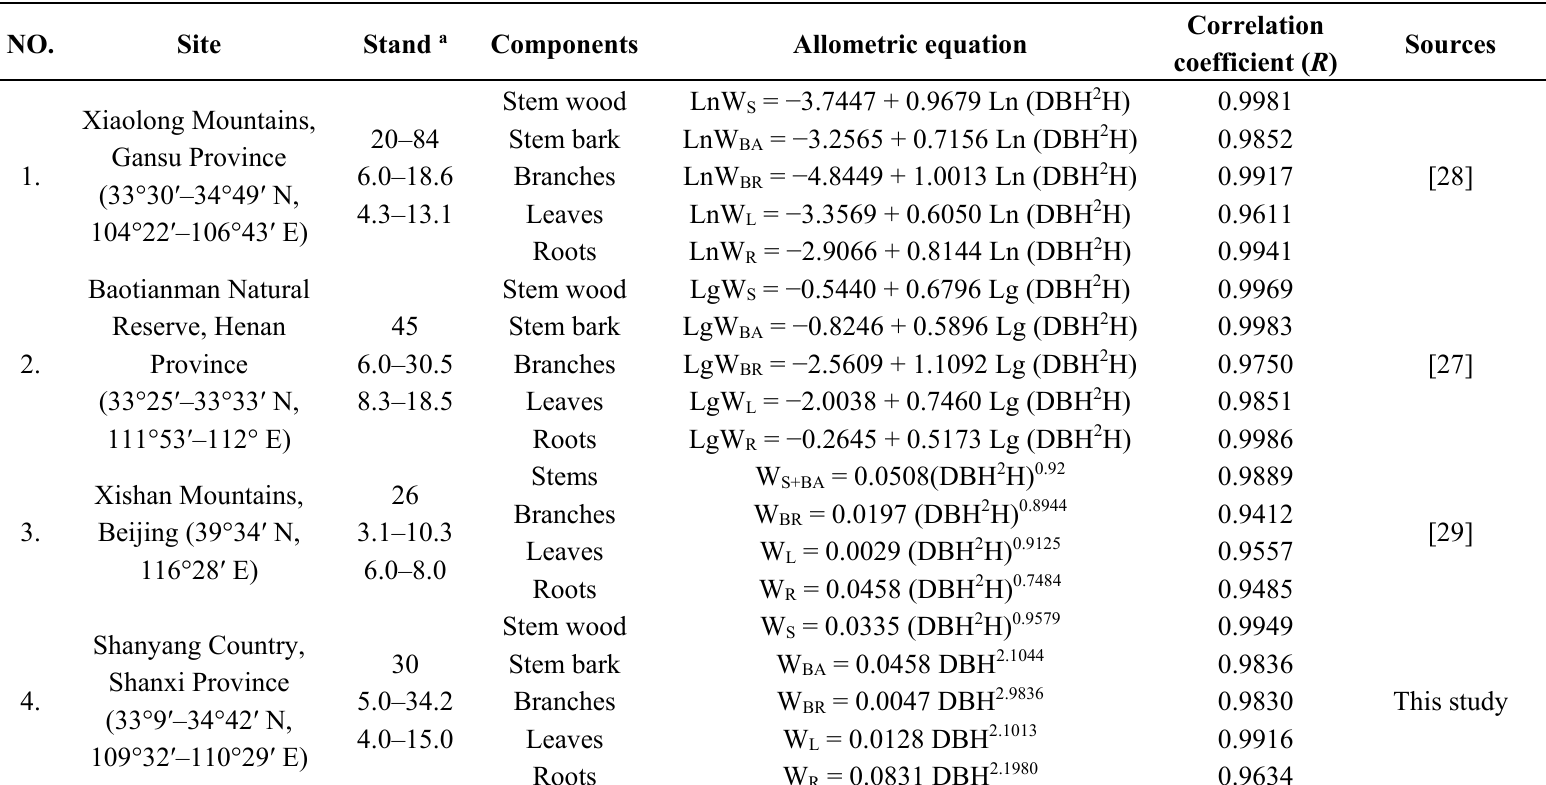
Table 1. Collection of the available allometric equations used to calculate biomass of the various tree components for Chinese cork oak forests in China.